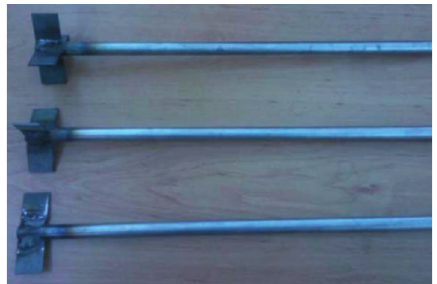
Figure 13: Stirrer with two, three, and four blades